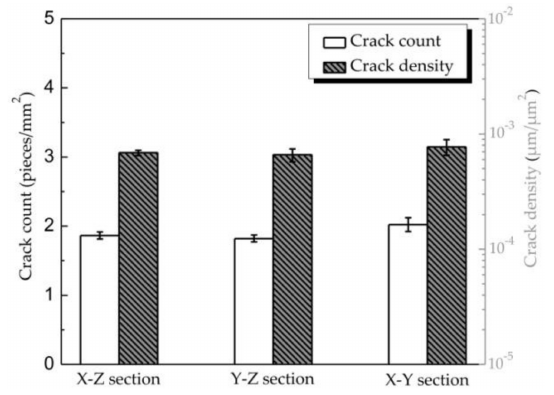
Figure 16. Crack count and density on three sections of as-remelted LFRed K417G.